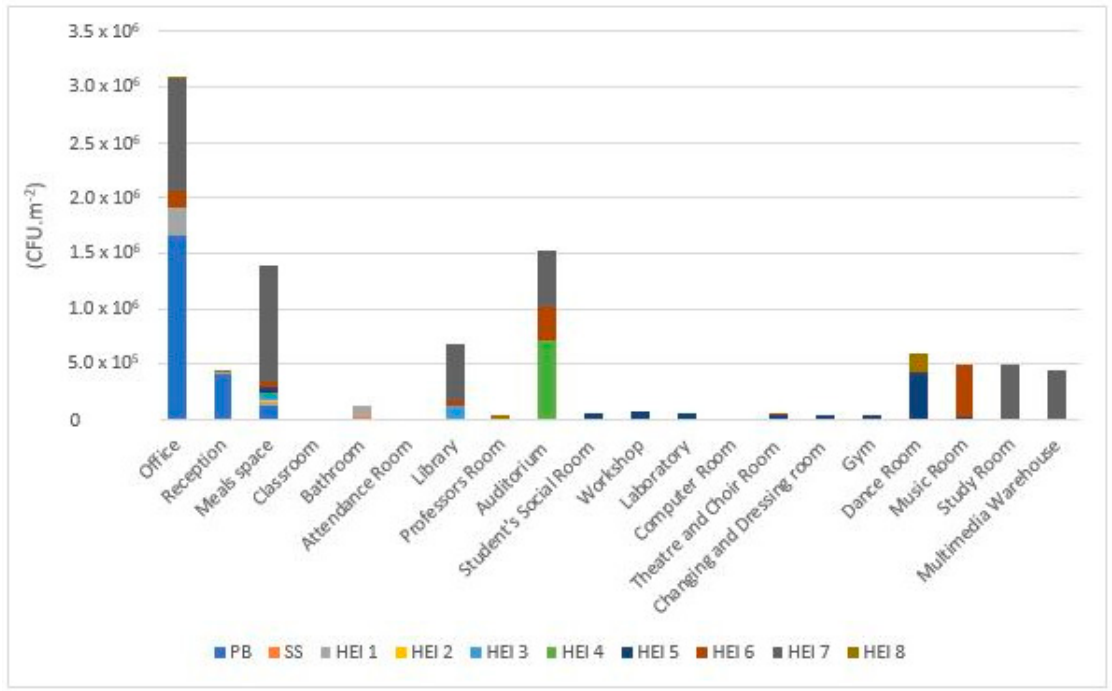
Figure 2. Total bacteria in surface swabs. Total bacterial contamination found in different facilities ranged from 3.8 × 10 4 (HEI 2) to 4 × 10 6 CFU · m − 2 (HEI 7), with the highest median value found in HEI 7 (5 × 10 5 CFU · m − 2 ) and the lowest median value found in Social Services (2 × 10 3 CFU · m − 2 ). Gram-negative bacteria ranged between 0 to 3 × 10 4 CFU · m − 2 (HEI 3), with a highest median value of 4 × 10 3 CFU · m − 2 (HEI 3) (Figures 2 and 3). Fungal contamination on surfaces ranged from 0 to 1.5 × 10 5 CFU · m − 2 (offices) on MEA, and from 0 to 1.8 × 10 5 CFU · m − 2 (professors room) on DG18. The median values (or total values in the case of classroom, attendance room, computer room, changing and dressing room, gym, study room and multimedia) ranged from 0 to 5.9 × 10 4 CFU · m − 2 (changing and dressing rooms) in MEA, and from 0 to 9.1 × 10 4 CFU · m − 2 (professors room) in DG18 (Figures 4 and